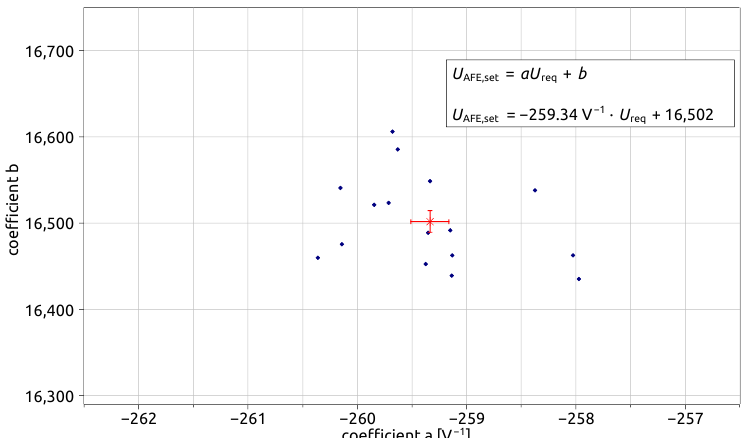
Figure 17. Distribution calibration coefficients across many AFEs for AFE voltage supply. The scale is limited to a narrow range to show small differences in presented values. The average values are marked with a red marker and given as an example below the